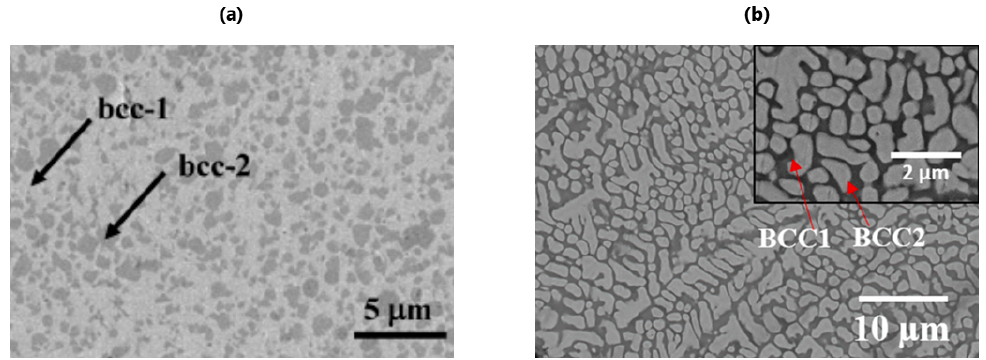
Figure 3. ( a ) SEM image showing the two BCC regions for HEA TiNbTaMoZr (from [48]); ( b ) SEM image of HEA MoNbTaTiZr showing the BCC1 region (dark region) and BCC2 (light region) (from [18]). Reprinted with permission from Elsevier: Mater. Chem. Phys. Copyright 2022, Li- cense: 5350300554948.